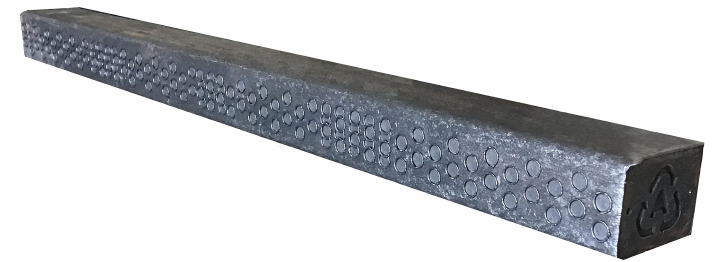
Figure 1. Example of a composite